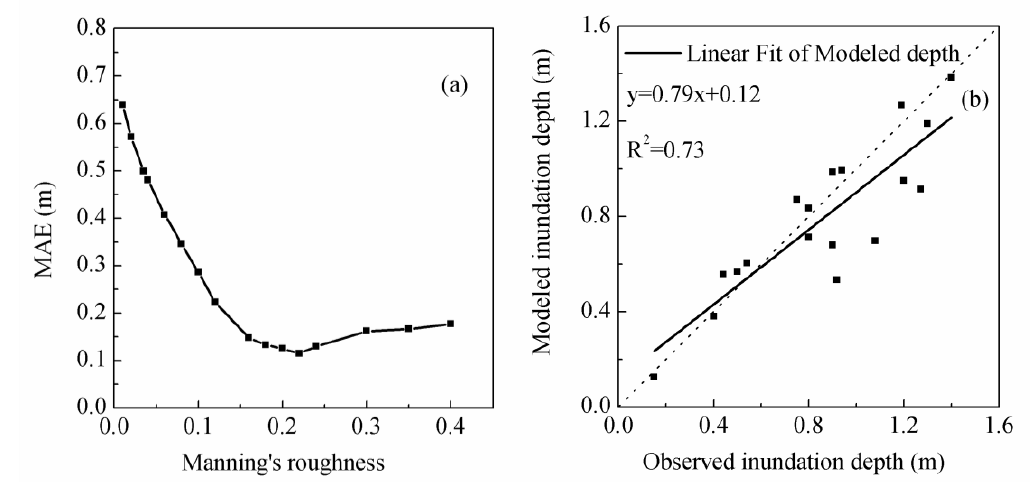
Figure 5. (a) MAE of different values of Manning‘s roughness from 0.01 to 0.4; (b) comparison of the observed and modeled inundation depth using Manning‘s roughness of